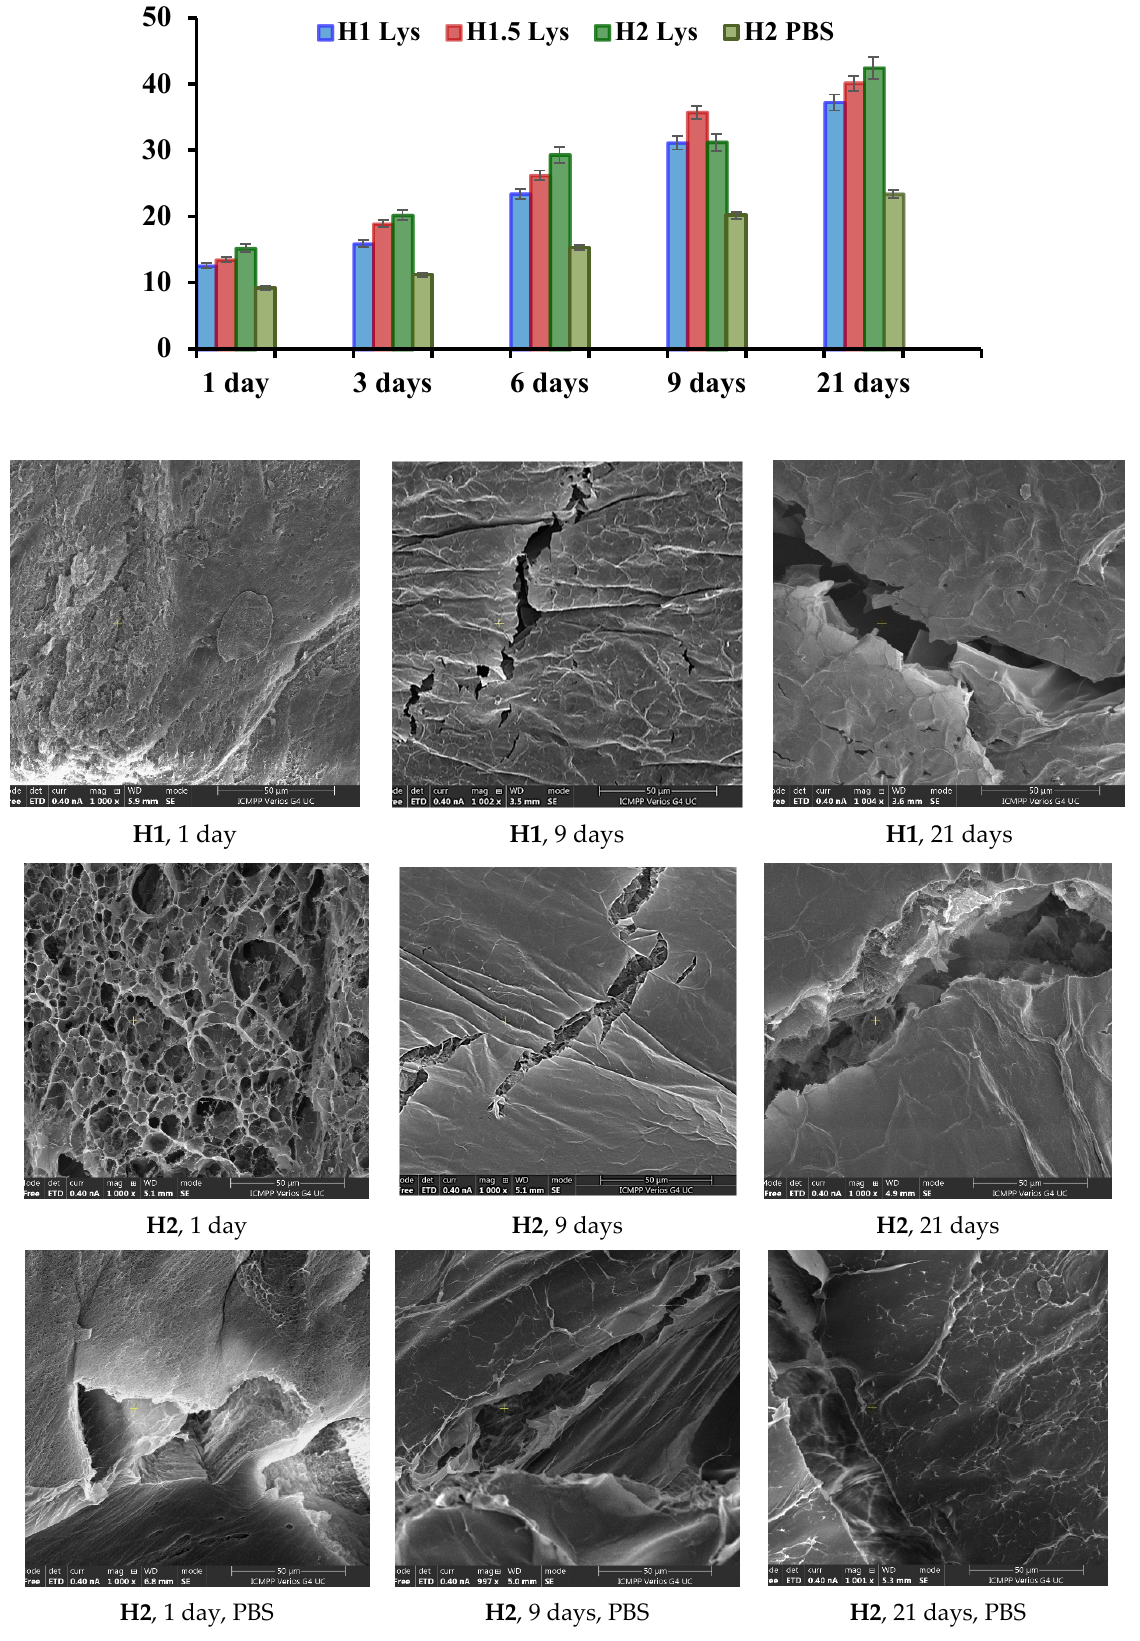
Figure 5. Mass loss of the samples during the in vitro enzymatic degradation tests and representa- tive SEM images postdegradation. SEM images